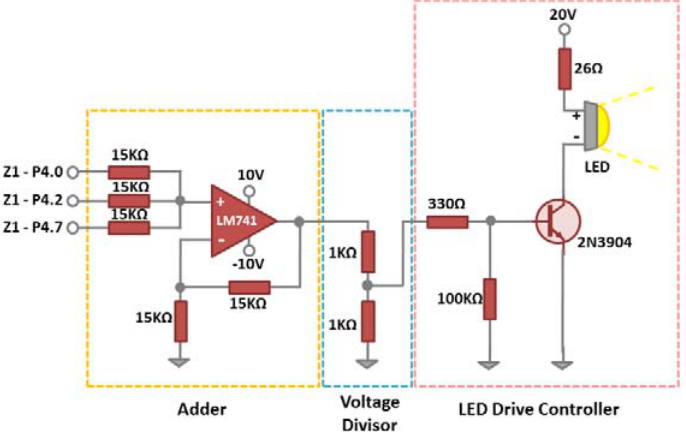
Figure 10. LED drive circuit developed.